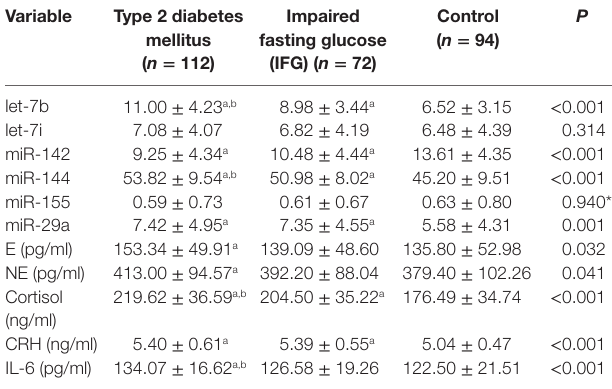
significantly associated with T2DM and IFG, even after adjust­ ment for possible confounding variables ( P < 0.05) ( Table 6